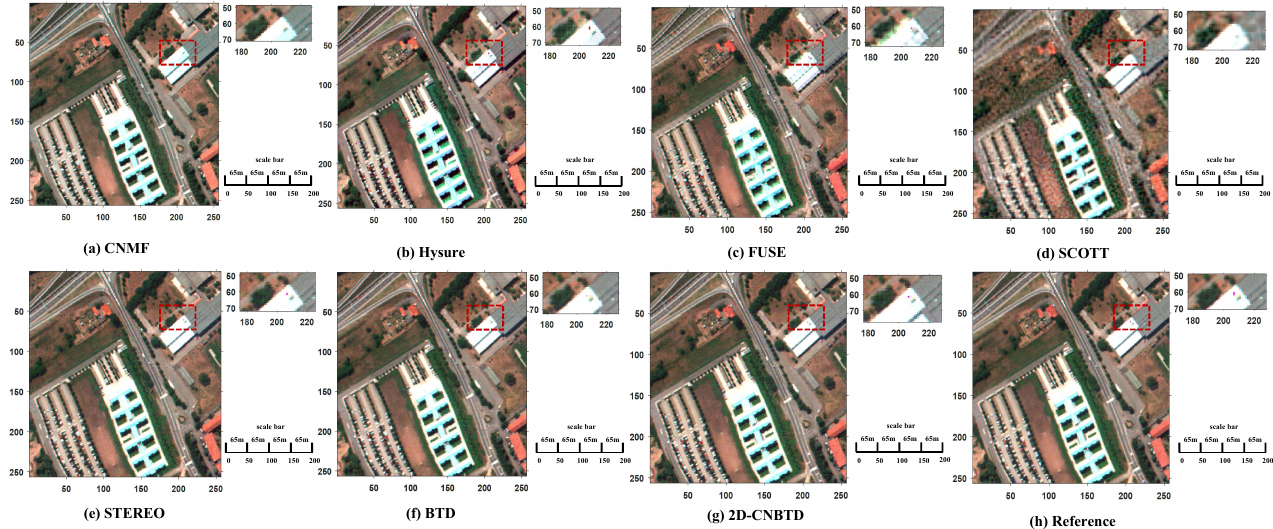
Figure 9. Graph of reconstructed HRHS results for Pavia University dataset.